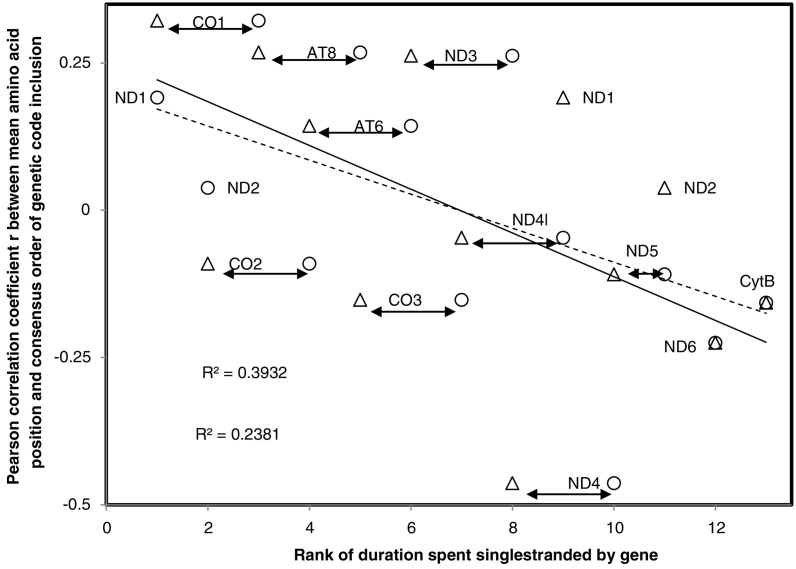
Association between mean amino acid position in the 13 human mitochondrion-encoded proteins and amino acid consensus inclusion order in the genetic code as a function of ranked times spent singlestranded by corresponding mitogenes during transcription (circles, continuous line) and during replication (triangles, discontinuous line). Mutations increase with singlestrandedness. Results indicate that amino acid mean positions reflect their genetic code inclusion order because this order increases tolerance of protein folding to mutations. This constraint affects less genes/proteins with lower mutation rates (low values for x axis). The y axis is identical for replicational and translational singlestrandedness, gene identity is indicated at mid-distance between points corresponding to replicational versus translational singlestrandedness (x axis). For ND6 and CytB, singlestrandedness is identical according to both replication and translation.